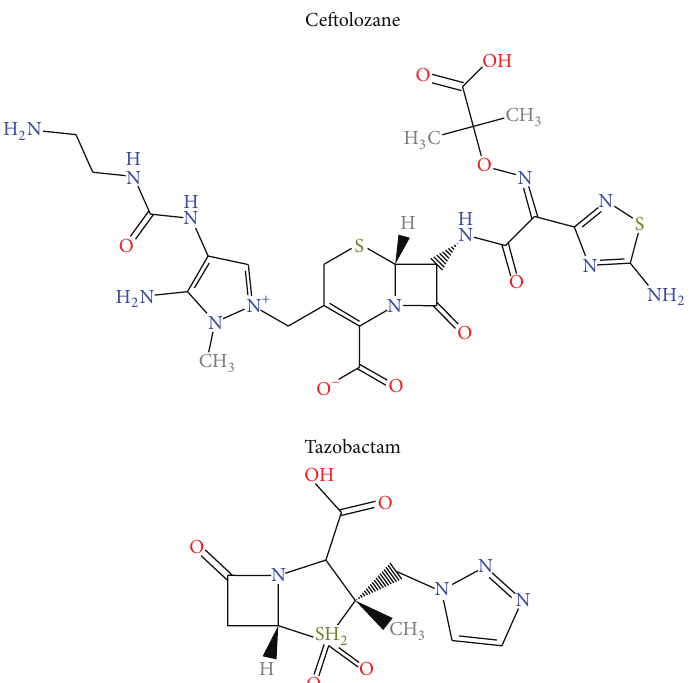
Figure 1: Chemical structure of